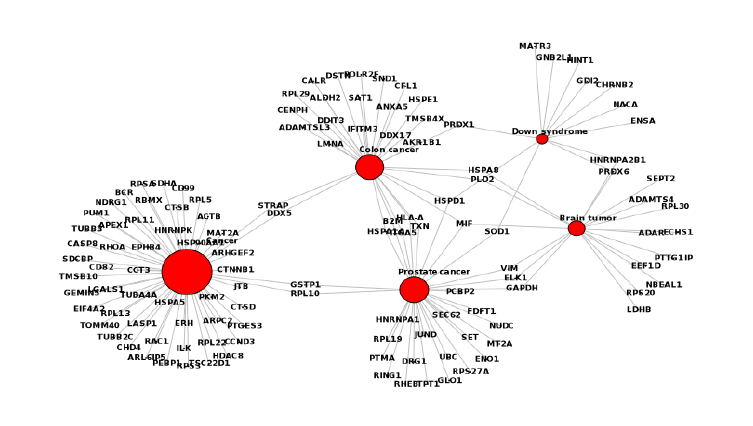
Figure 2: The mapping between genes and diseases in HA for DO enrichment analysis generated by FunDO. Table 4 ： Enriched terms in HA and GSEA procedures for skeletal muscle and retina